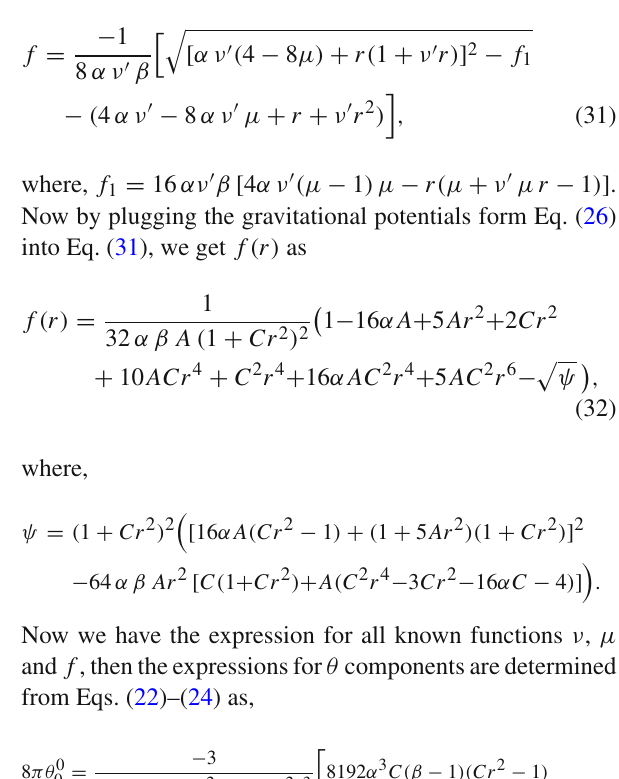
3.1 Solution A: mimicking of the pressure constraint i.e. = θ 1 ˆ p r